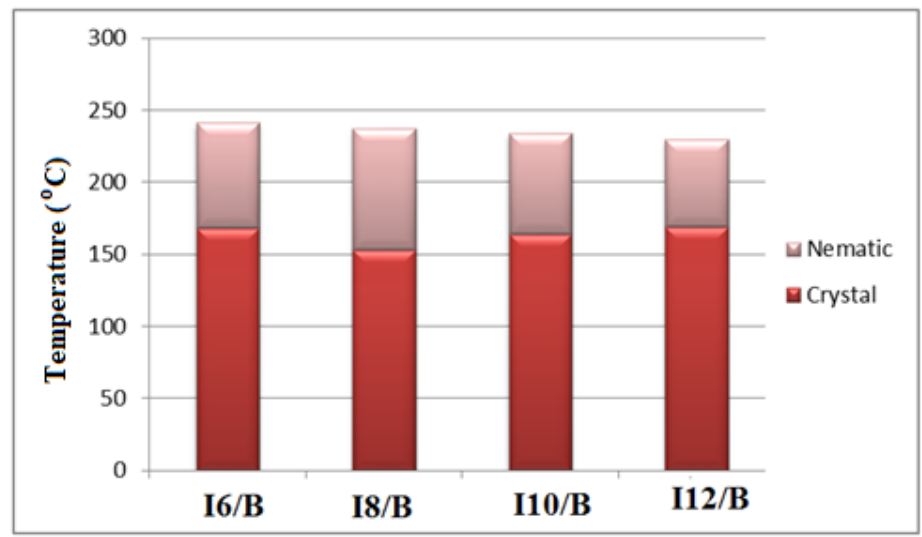
Figure 2. Graphical DSC transitions of the 2:1 supramolecular complex series, In / B .